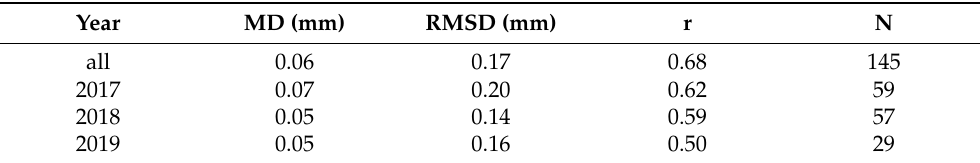
Table 2. Comparison statistics between the measured and retrieved snow optical grain diameter at EastGRIP: Mean difference (MD), Root Mean Squared Difference (RMSD), Pearson’s correlation coefficient (r) and number of days used for comparison